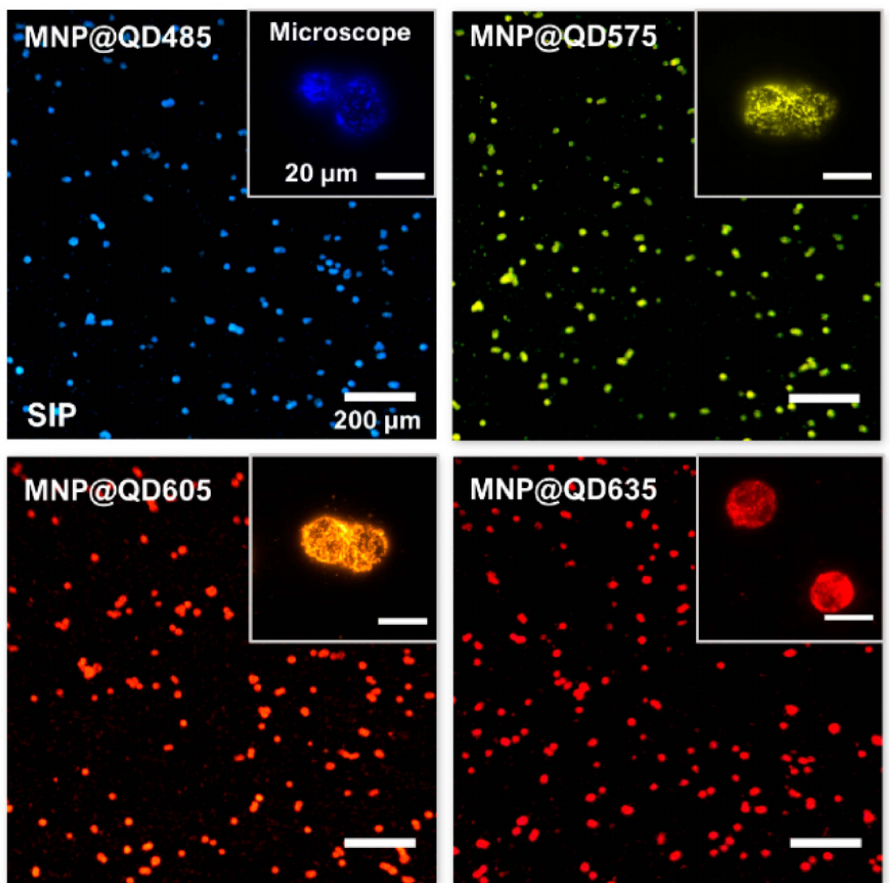
Figure 17. Smartphone (main images, scale bar = 200 m) and microscope (insets, scale bar = 20 m) images of fixed SK-BR3 cells isolated with MNP@QDs of different colors: QD485, QD575, QD605, and QD635. The notation for the QDs indicates the QDs’ peak PL emission wavelengths. The smartphone pictures were taken in RGB color format. The microscope images were given “false colors” based on the monochrome intensity values